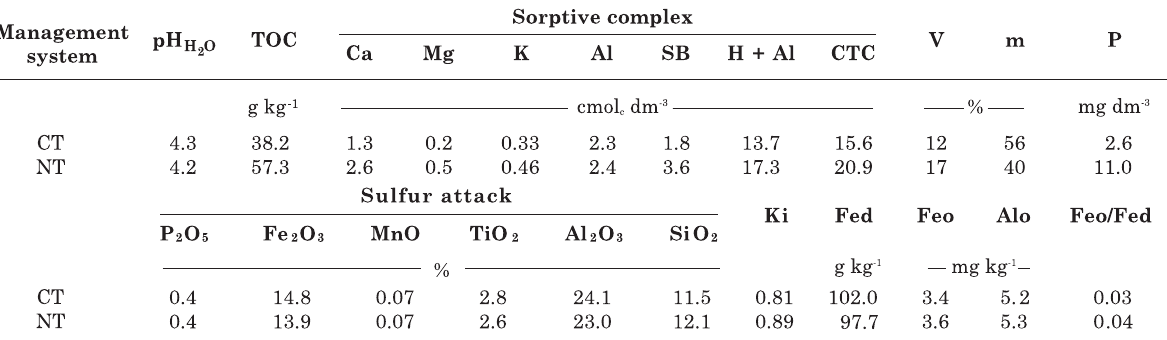
Table 1. Chemical characteristics of the solid phase of a subtropical Oxisol under conventional tillage (CT) and no-tillage